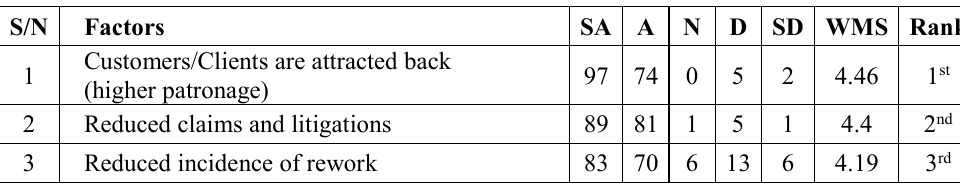
Table 6. Benefits of Quality Assurance Management Application in